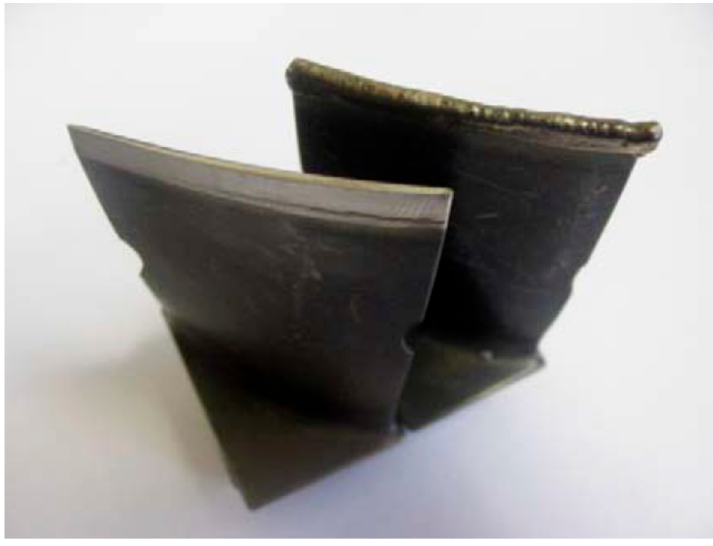
Figure 16. Thin-curved compressor blade before and after repairing [91].